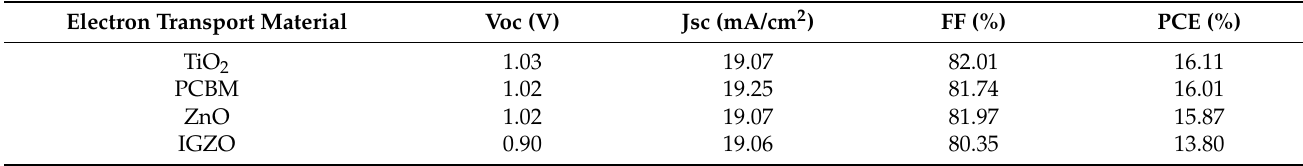
Figure 5. Band alignment between ETL materials and CCSCNCs. Table 5. Performance parameters of different ETMs as ETL. Electron Transport Material